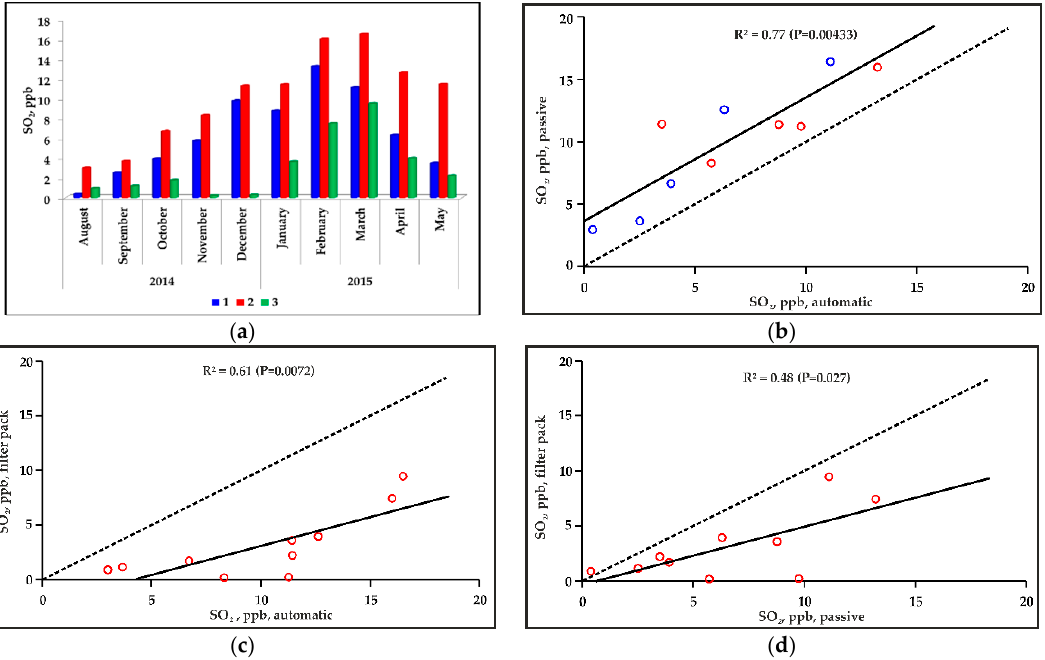
Figure 6. Sulfur dioxide concentration at the Irkutsk monitoring site in 2014–2015, shown in graph ( a ); correlation of the concentrations obtained using the automatic measurement and passive sampling methods shown in ( b ); concentration interconnection using the automatic measurement and samples selected by filter pack method ( c ); concentration interconnection using the passive measurement and samples selected by filter pack method ( d ). 1—Passive method; 2—Automatic method; 3—Filter pack method. In the figures ( b – d ), the red circles show the data obtained with a two-week exposure of the passive sampler, the blue circles ( b ) show the data obtained with the monthly exposure of the passive sampler. The solid line is a plot of the estimated regression model, the dotted line is the expected relationship with slope = 1 and intercept = 0. The figures show the value of the quality of the linear approximation R 2 and its statistical support P.